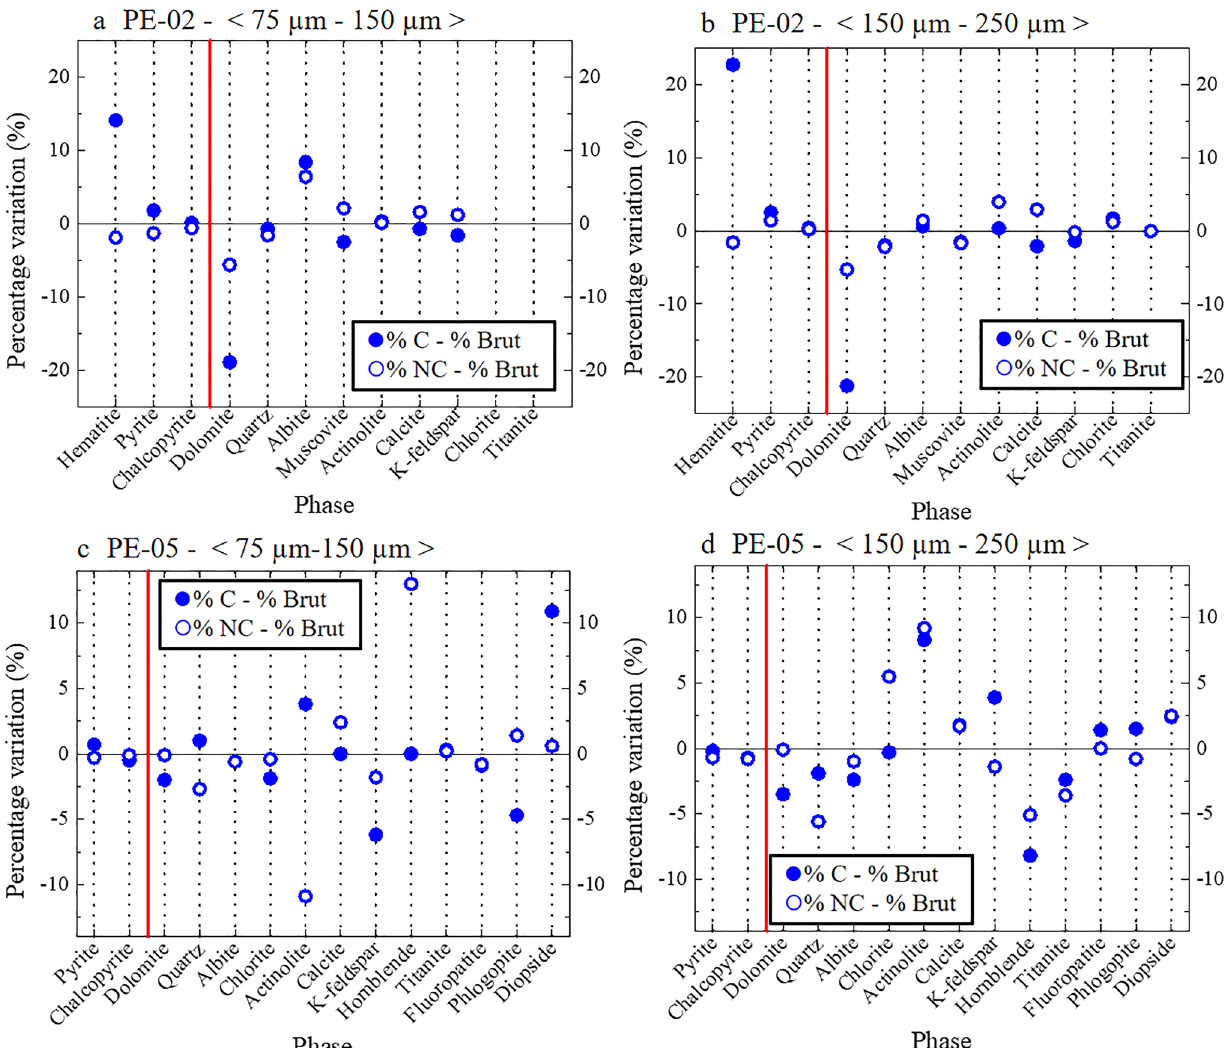
250 μ m>. Filled symbols correspond to %C - %Brut and empty sym- bols to %NC - %Brut. The red solid line separates the conductor (hematite, pyrite and chalcopyrite) from the non-conductor (dolo- mite, quartz or albite) mineral